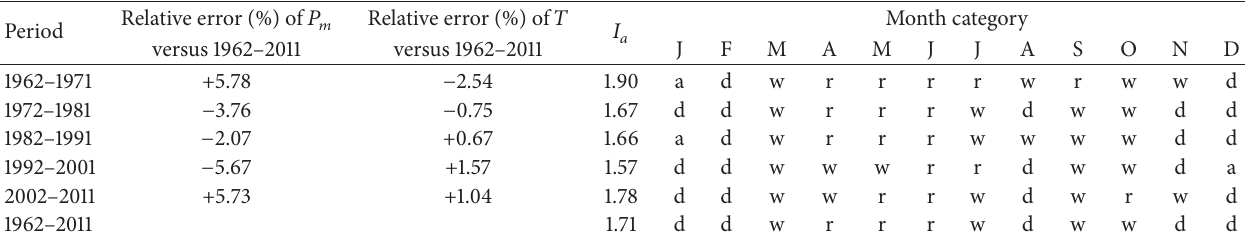
Table 1: Pluviothermal index (𝐼 𝑎 ) , month categories, and the relative difference between each decade and the entire period for both variables. Period